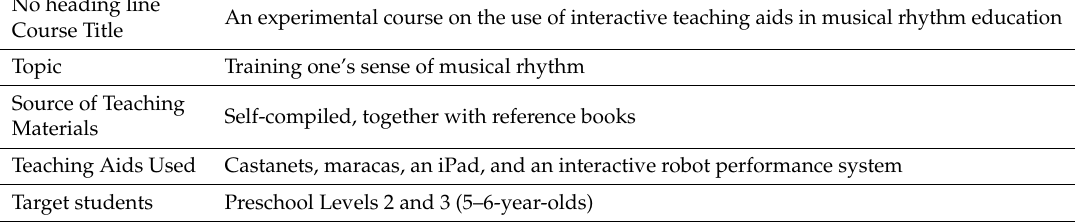
Table A1. Teaching plan for music rhythm